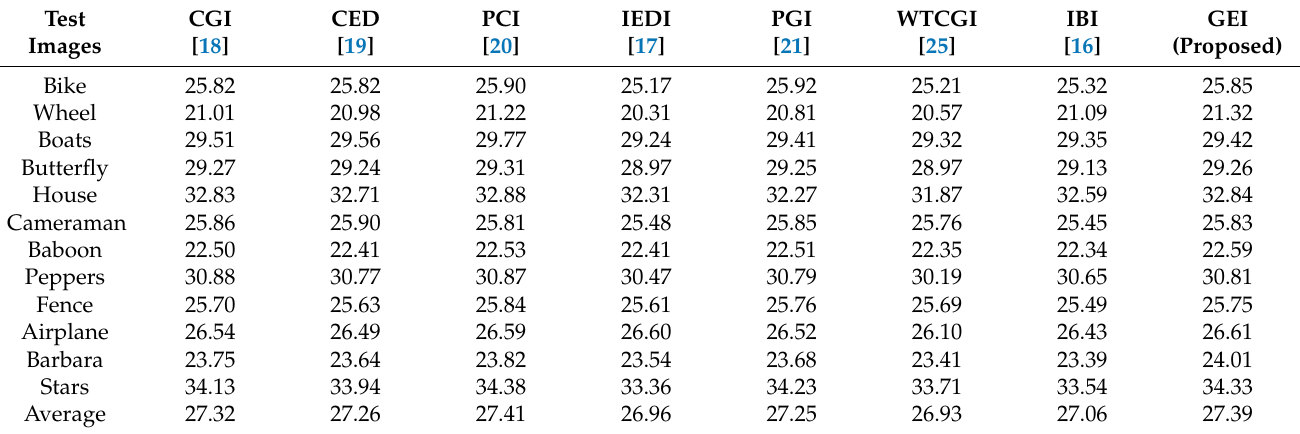
Table 2. A comparison of different interpolation methods with respect to the PSNR (dB).